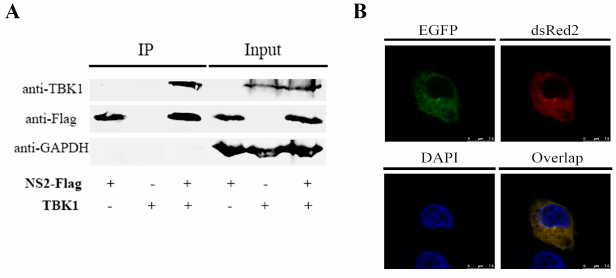
Figure 5. Analysis of the interaction between NS2 and TBK1. ( A ) Flag-tagged NS2 was co-transfected with Myc-tagged TBK1 into F81 cells for 36 h. The cell lysates were immunoprecipitated using ANTI-FLAG M2 magnetic beads. The whole-cell lysates and immunoprecipitation complexes were analyzed by immunoblotting using anti-Flag or anti-Myc antibodies. ( B ) F81 cells were co-transfected with the pDsred-TBK1 plasmid and pEGFP-NS2 plasmid. Twenty-four hours after transfection, laser scanning